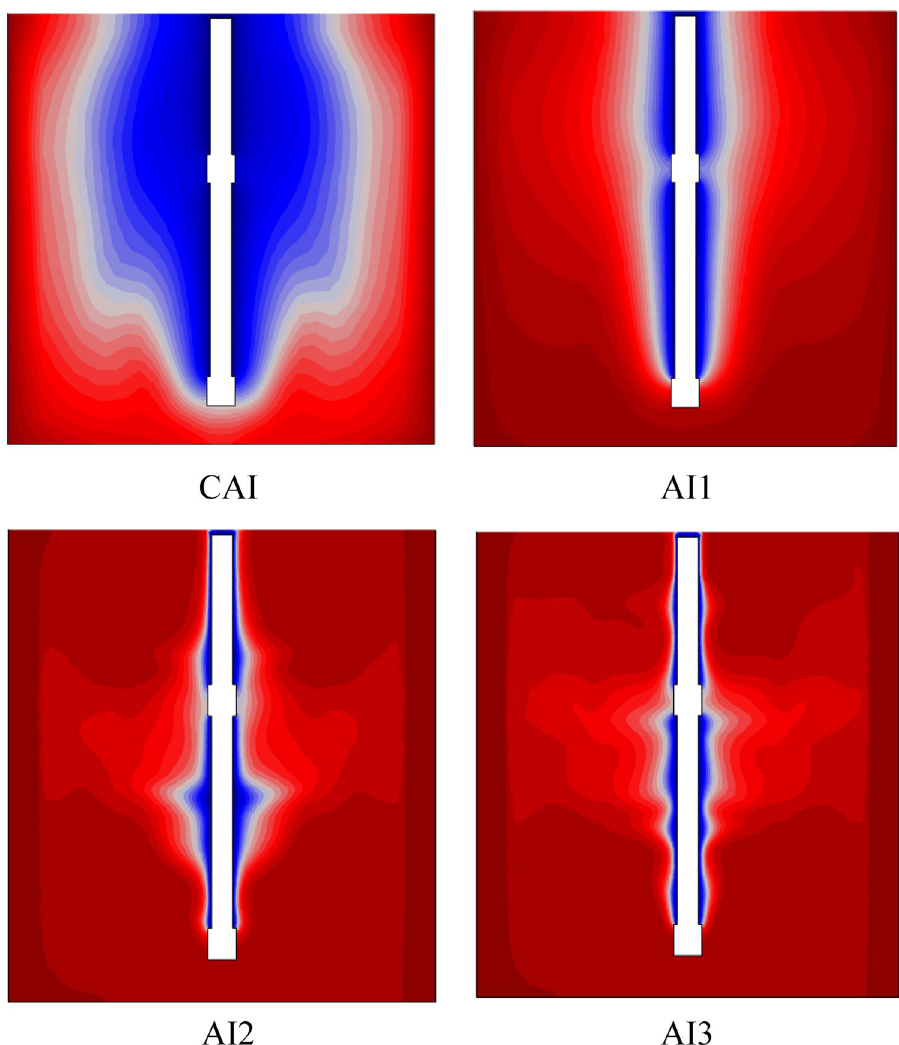
Figure 25. Isotherm distribution on the vertical section of the vessel with different geometry configurations.